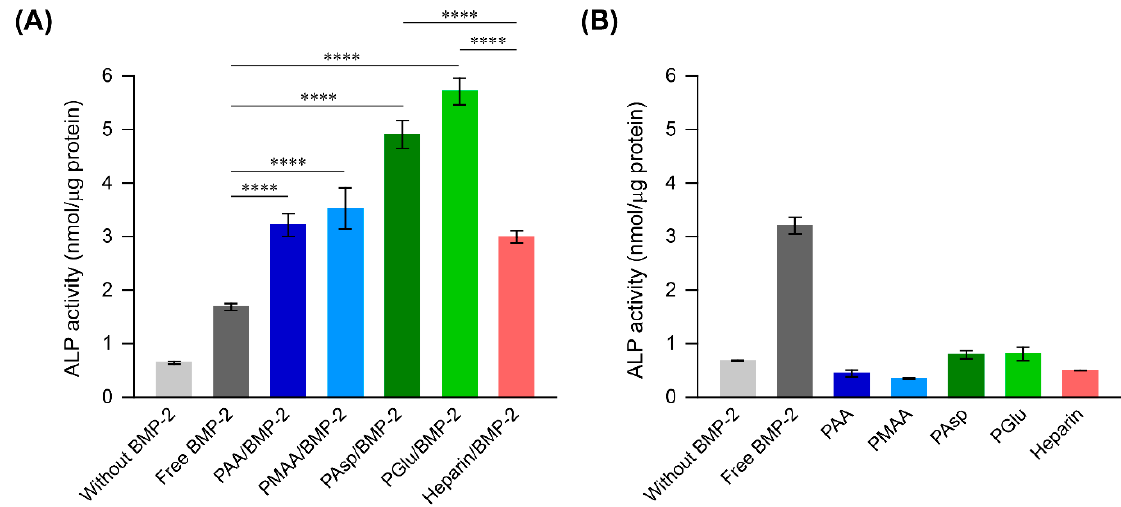
Figure 5. ( A ) Alkaline phosphatase (ALP) activity in MC3T3-E1 cells after 72 h of treatment with free BMP-2, polycarboxylate / BMP-2 complexes, and heparin / BMP-2 complex at polymer and BMP-2 concentrations of 500 µ g / mL and 50 ng / mL, respectively (n = 3 in a single experiment). ( B ) ALP activity in MC3T3-E1 cells after 72 h of treatment with free BMP-2 (50 ng / mL), polycarboxylates (500 µ g / mL), and heparin (500 µ g / mL) (n = 3 in a single experiment). The data are expressed as the mean ± SD (**** p < 0.001).